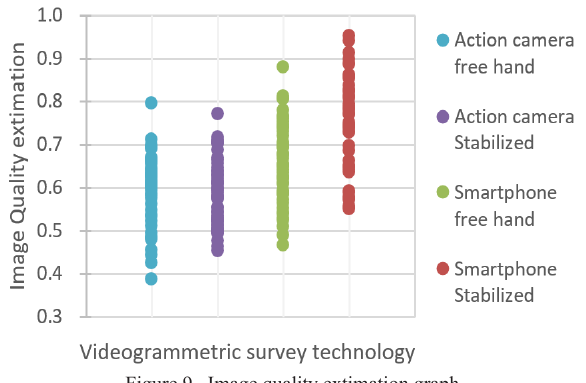
Figure 9. Image quality extimation